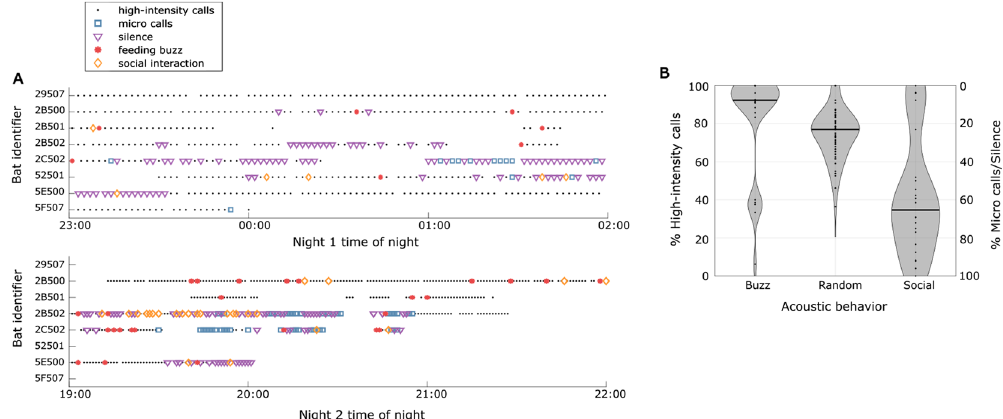
Figure 2. Acoustic behavioral patterns. ( A ) Time course of echolocation behaviors over the first and second nights of recording for eight individual hoary bats. Ten second data clips were recorded once every three minutes on the first night and once per minute on the second night. Data gaps reflect periods when bats were determined to not be flying. ( B ) Violin plot showing percent of recordings occurring within 15 min of different acoustic behaviors that are predominated by high-intensity calls vs micro calls or silence. Black dots show individual data points; grey areas indicate probability density functions. Note that feeding buzzes tend to occur more often during periods of high-intensity echolocation compared to if acoustic behaviors were randomized (“random”), whereas social interactions are more common when bats employ micro calls and